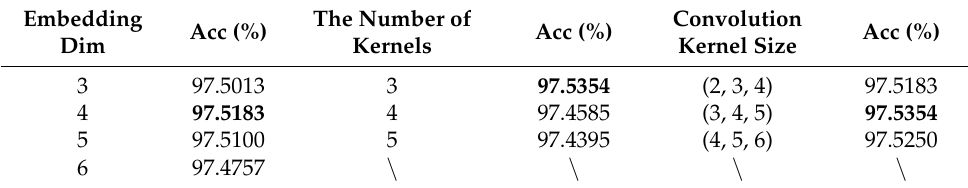
Table 4. Experimental results of different